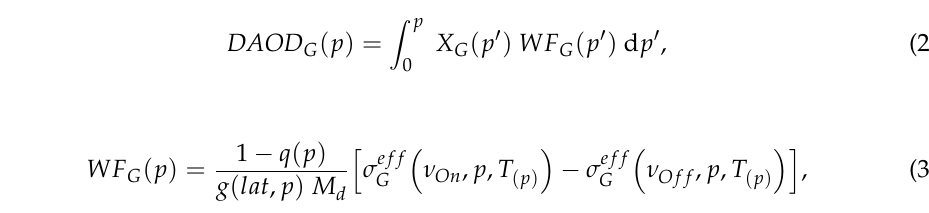
, V (cid:48) , V (cid:48) , 2 3 1